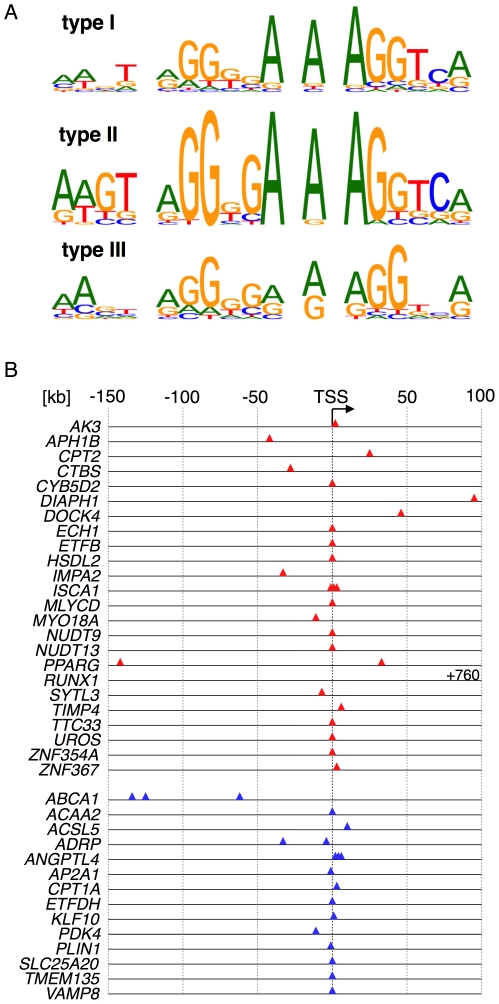
Structural features of PPARβ/δ target genes showing type I or type II responses.(A) Consensus PPRE motifs in ChIP-Seq peak areas of validated type I, II and III response genes derived by best-fit alignment of peak sequences with the FDR = 0 motif in Fig. 2C. (B) Locations of PPREs in PPARβ/δ enrichment peaks (type I: red; type II: blue; numbers relative to the TSS). All sites downstream of the TSS are intragenic.